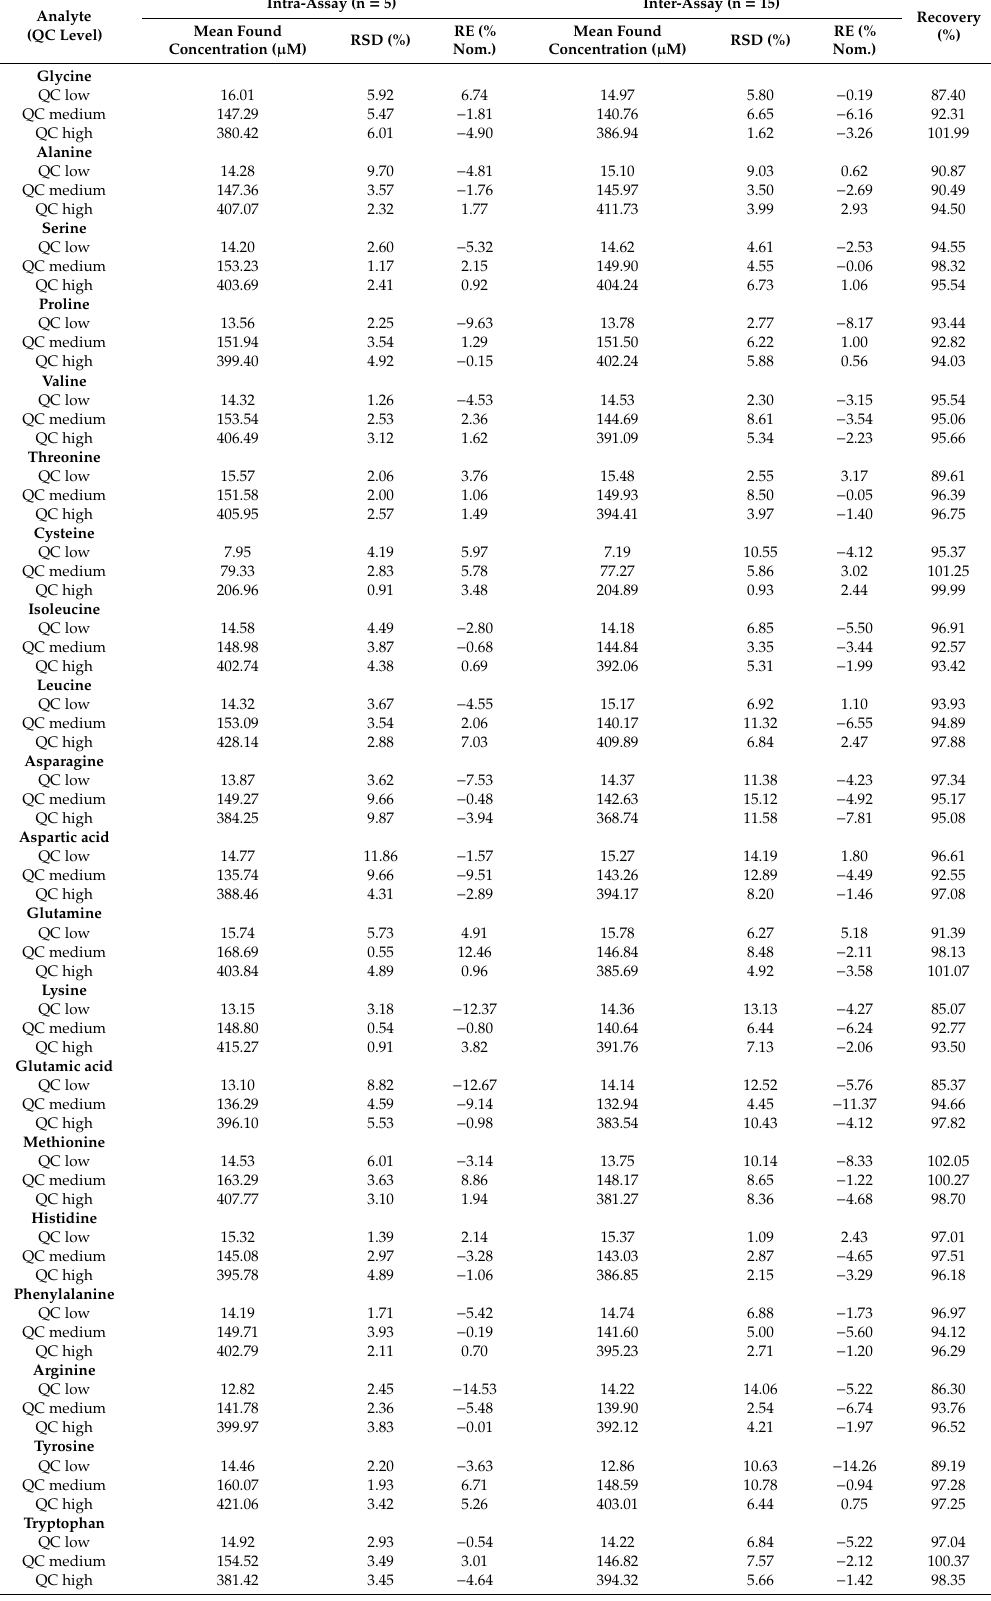
Table 3. Accuracy, precision and recovery data from quality control (QC) samples. Analyte (QC